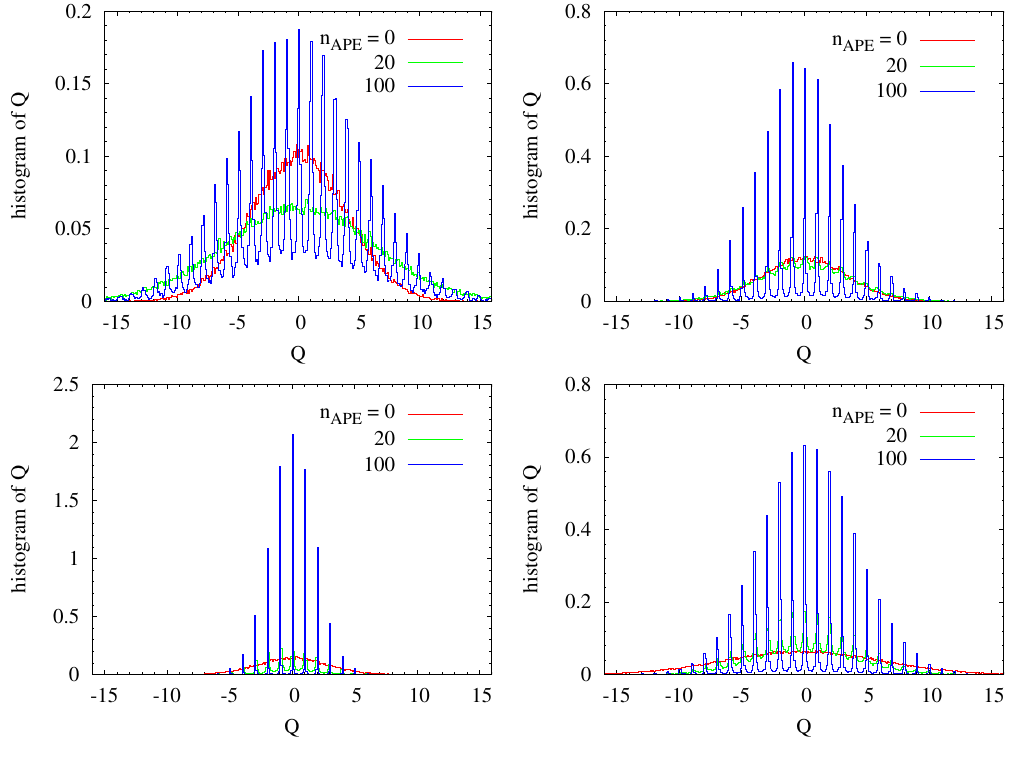
Figure 7 . Histogram of Q for four ensembles at n APE = 0 , 20,